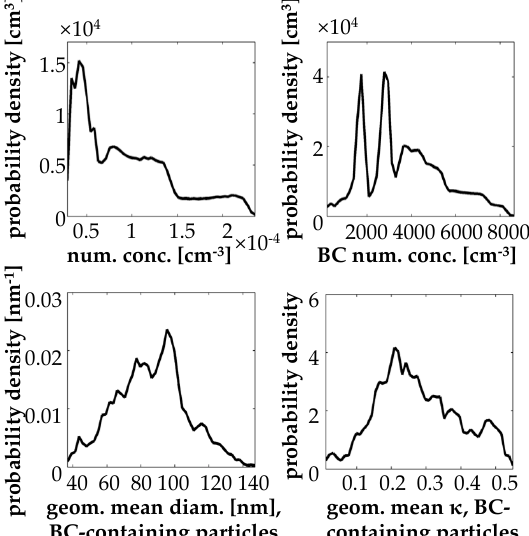
Figure 4. Probability density function of (a) total aerosol num- ber concentration, (b) total number concentration of BC-containing particles, (c) geometric mean diameter of BC-containing particles, and (d) geometric mean hygroscopicity parameter of BC-containing particles.